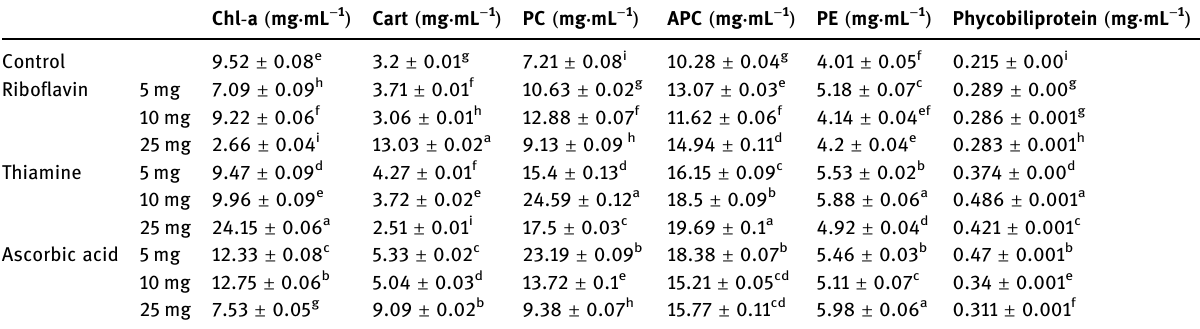
Table 3: Mean values of chlorophyll, carotenoids, and phycobilins concentrations ( mg · mL − 1 ) in SP supplemented with various concen - trations of ribo fl avin, thiamine, and ascorbic acid for 14 days of culture